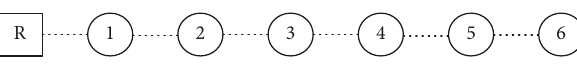
Figure 7: Logical view of the six-hop topology.